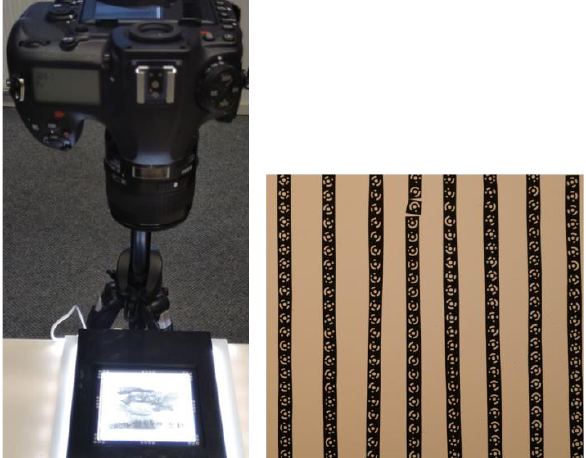
Figure 5: Camera with macro lens capturing the glass plate on a light table (left); test field for camera calibration (right).